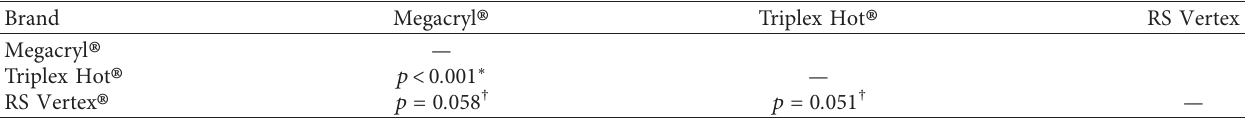
Table 5: Tukey multiple global comparisons between brands.